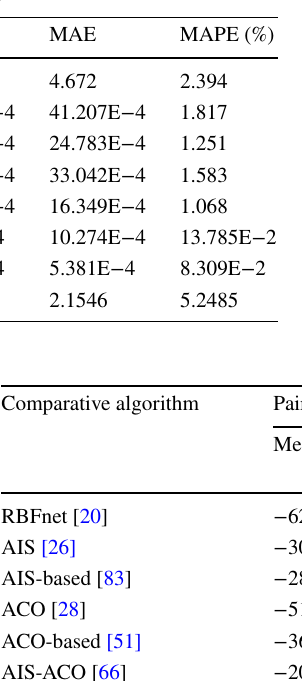
Table 6 The comparison of prediction variances for all relevant algo- rithms utilized in the crude oil spot price instance Comparative algorithm